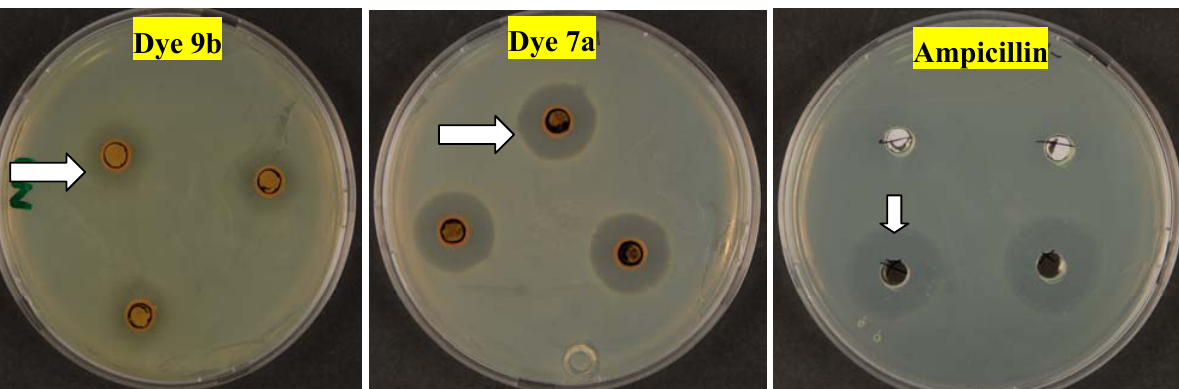
Figure 2. Staphylococcus aureus treated with 10 mg·mL − 1 of compounds 9b and 7a with comparison to Ampicillin after six days of